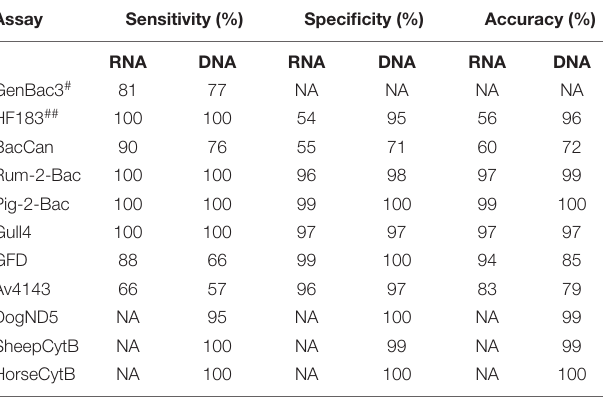
TABLE 4 | Performance characteristics of the MST assays when using RNA and DNA as a template.